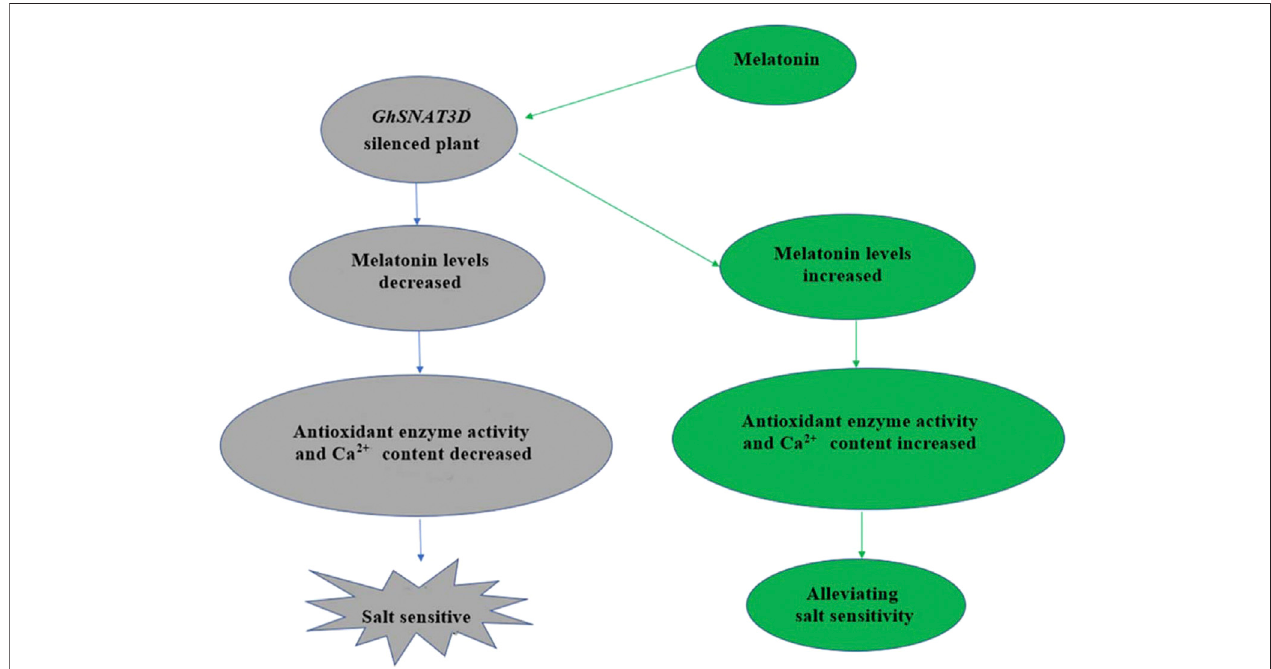
FIGURE 10 | Mechanism of GhSNAT3D in regulating cotton response to salt